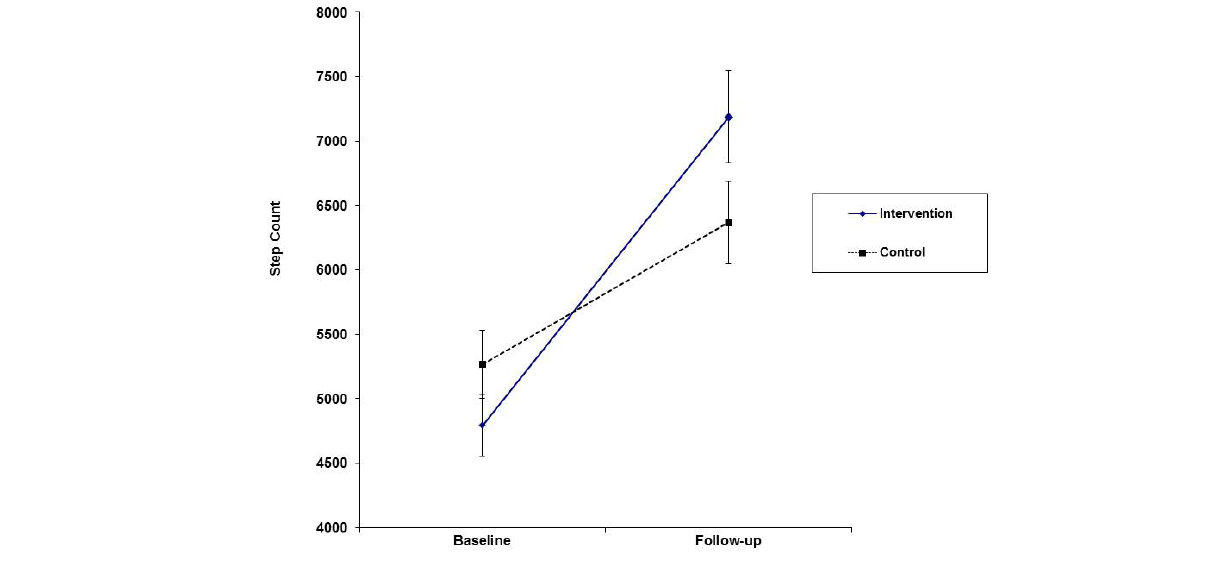
Figure 3. Graph showing interaction effect between time and